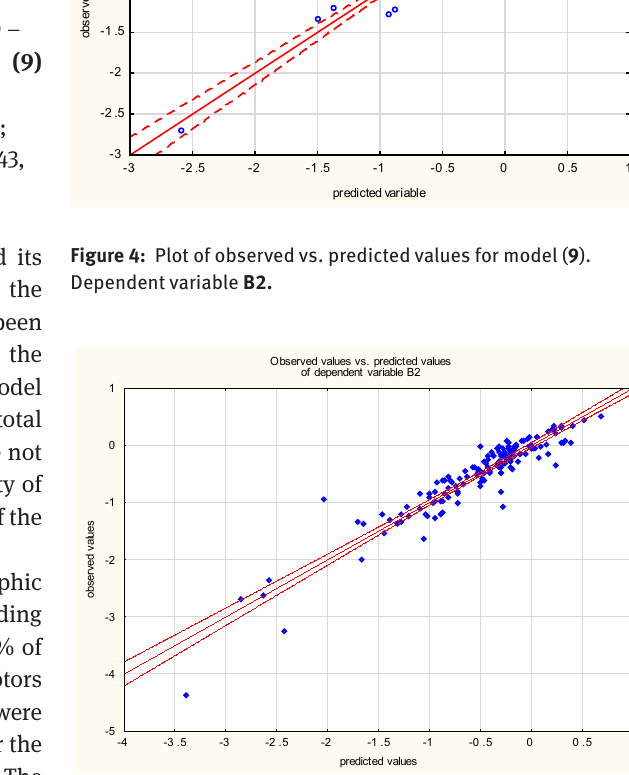
Figure 5: Plot of observed vs. predicted values for model ( 10 ). Dependent variable